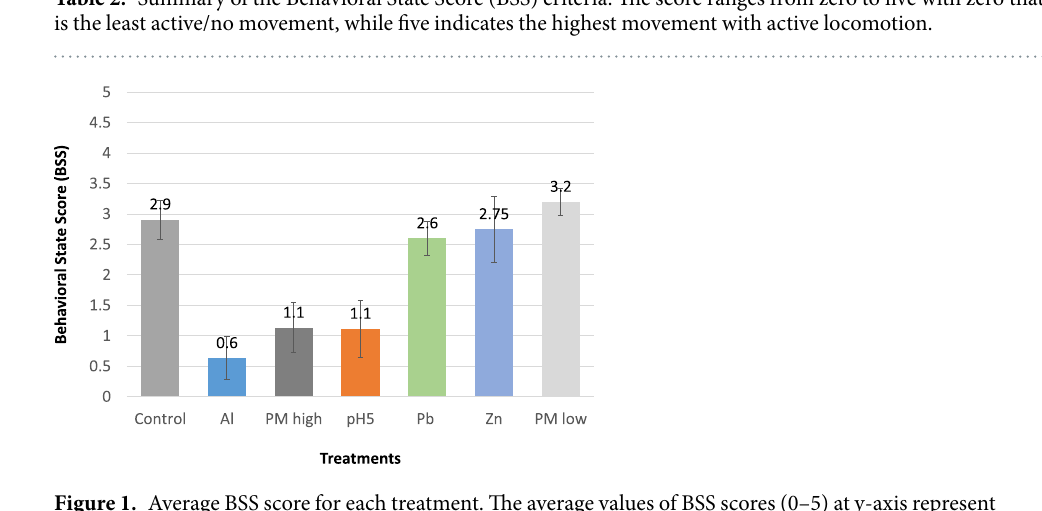
Figure 1. Average BSS score for each treatment. The average values of BSS scores (0–5) at y-axis represent mean ± SE for each treatment (x-axis). High PM2.5, pH 5, and aluminum treatments had significant BSS decrease in snail behaviors. In contrast, lead, zinc, and low PM2.5 did not show significant BSS